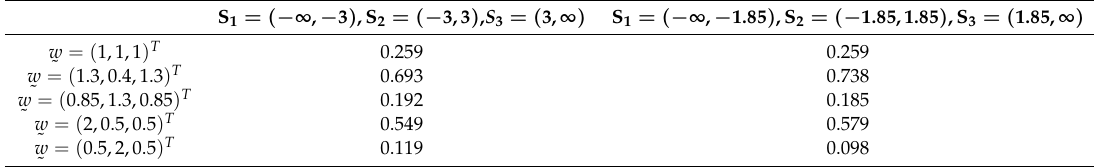
Table 4. CWKL divergence between P and Q in two different partitions of the